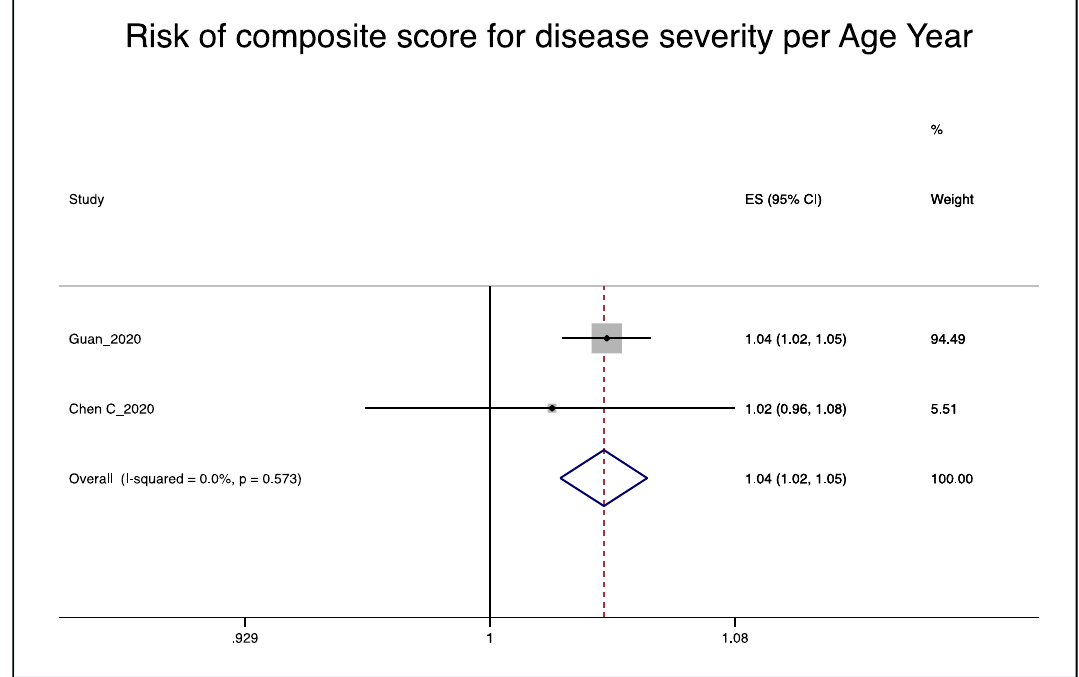
Figure 3. Pooled effect of the risk of age on disease severity, random-effects meta-analysis. Figure 3. Pooled e ff ect of the risk of age on disease severity, random-e ff ects meta-analysis.